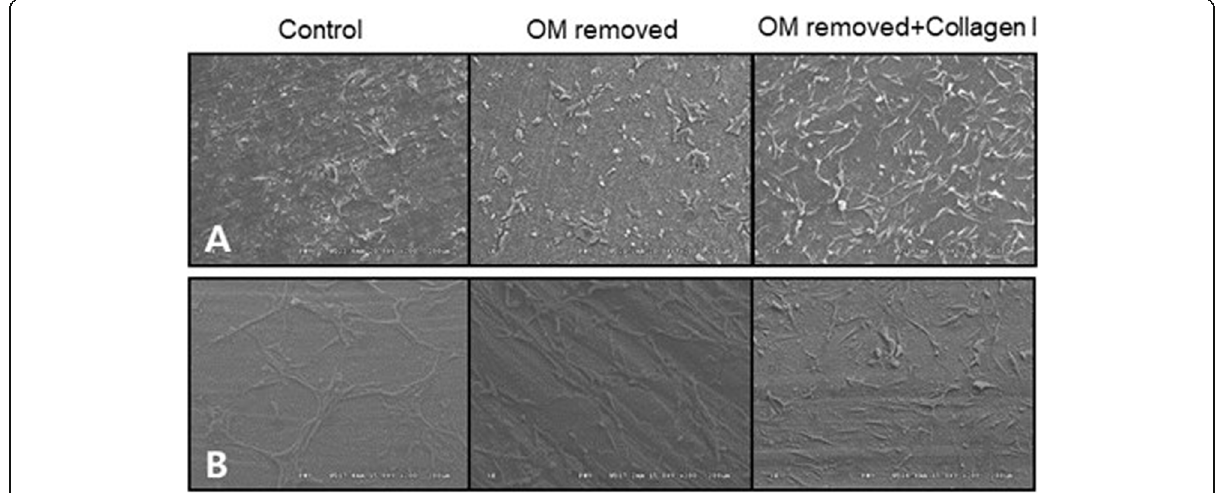
Fig. 4 AutoBT-grafted cell adhesion morphology of HOS cells ( A ) and MG63 cells ( B